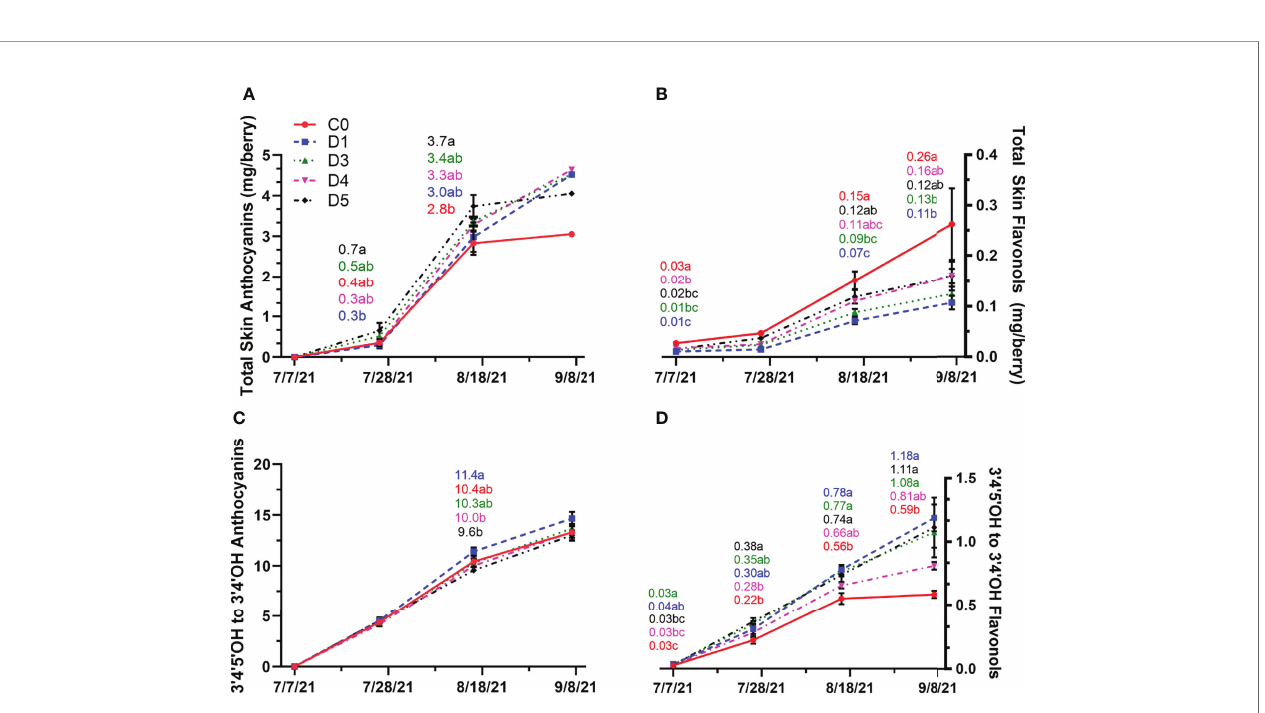
FIGURE 7 | Total skin anthocyanin (A) and fl avonol (B) content and anthocyanin (C) and fl avonol (D) hydroxylation pro fi le (ratio of 3 ’ 4 ’ -OH and 3 ’ 4 ’ 5 ’ -OH) throughout berry development in untreated (C0) and shade fi lm treatments (D1, D3, D4, D5) in 2021. Points are means ± standard error ( n = 4). Means with no letters in common are signi fi cantly different (p ≤ 0.05).